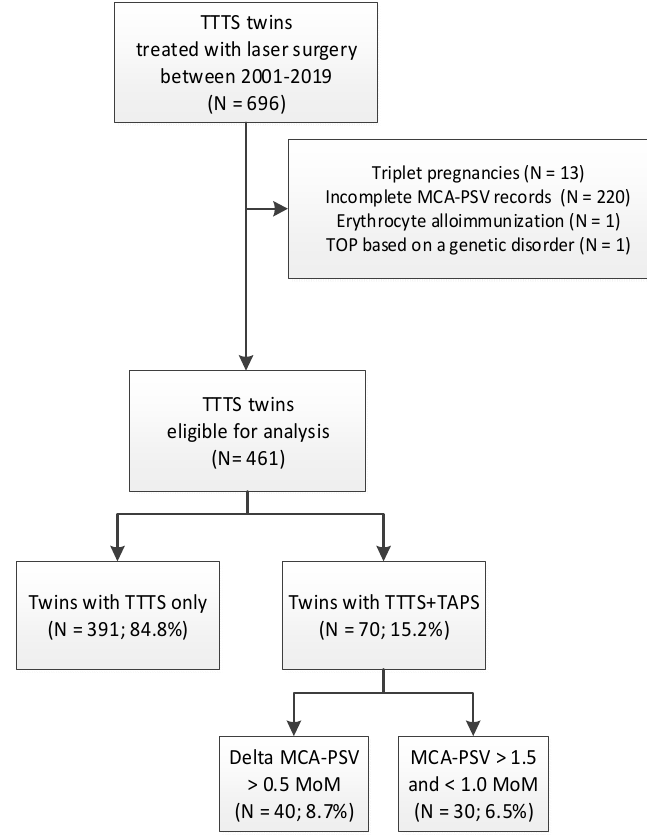
Figure 1. Flowchart of the derivation of the study population. TTTS: twin-twin transfusion syndrome; MCA-PSV: middle cerebral artery–peak systolic velocity; TAPS: twin anemia polycythemia sequence; MoM: multiples of the median.